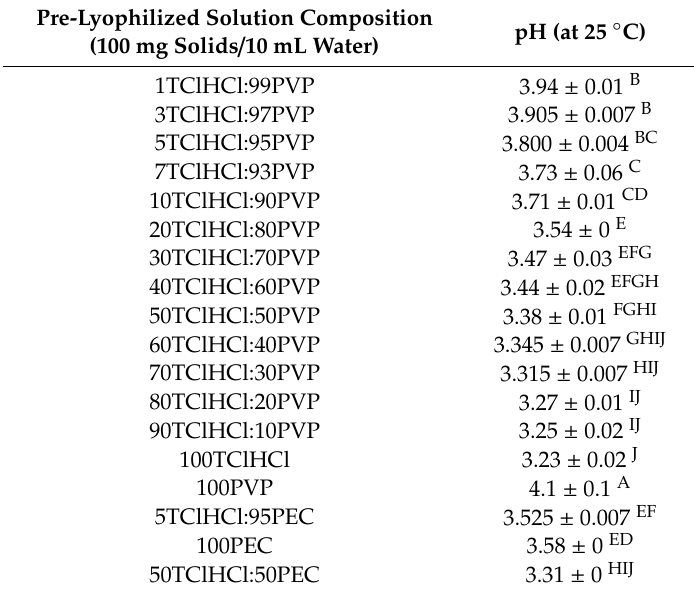
Superscript letters indicate statistical